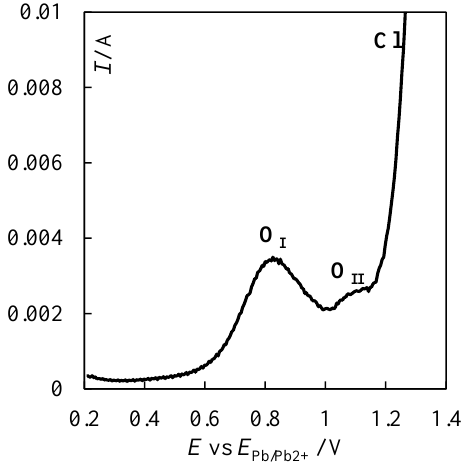
Figure 2. CVs in the initial PbCl 2 melt without the external addition of PbO at a potential sweep rate from 0.1 to 2 V s −1 and a temperature of 520 °C.